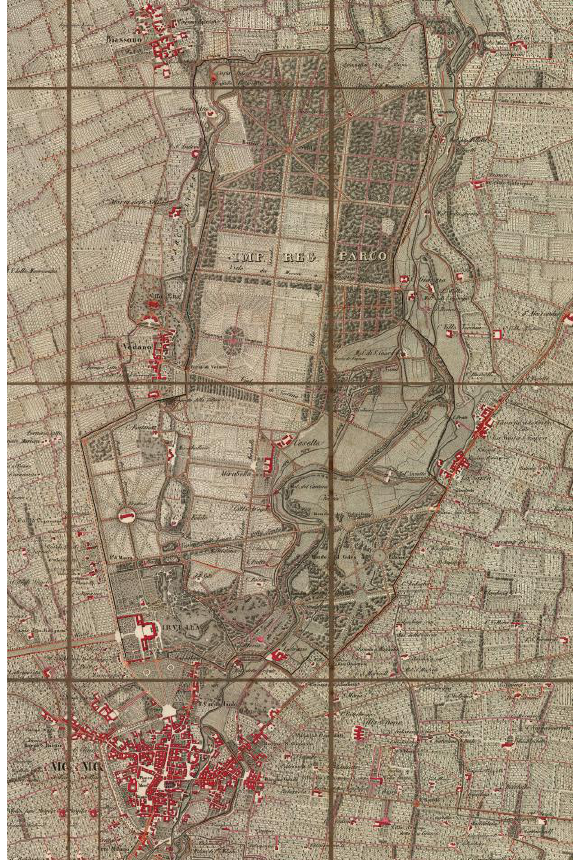
Figure 1. Topography of the city of Monza and of I.R. Villa with corresponding Park and surroundings surveyed on site and draw in the scale of 1:10.000 by the I.R. First